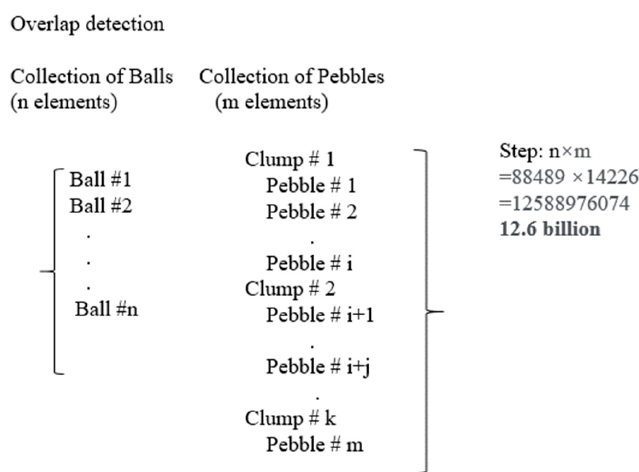
Figure 11. Original Objective Search Algorism.